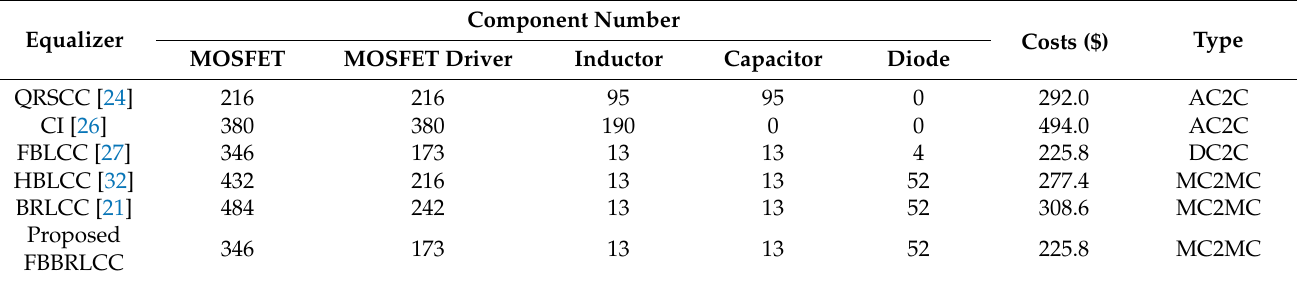
Table 7. Costs of different experimental